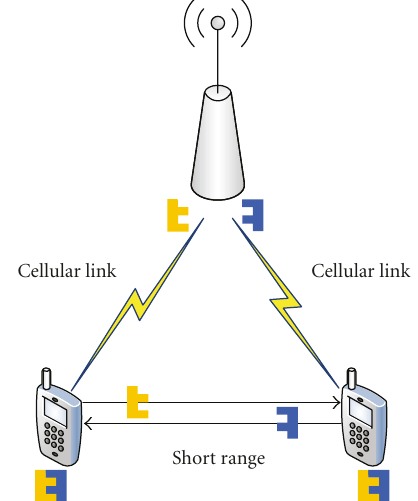
Figure 1: The figure shows the cellular controlled peer-to-peer (CCP2P) architecture. The mobile phones in the cooperating cluster receive half of the content over the cellular link and exchange it over a short range link. By doing that they can get the full content.